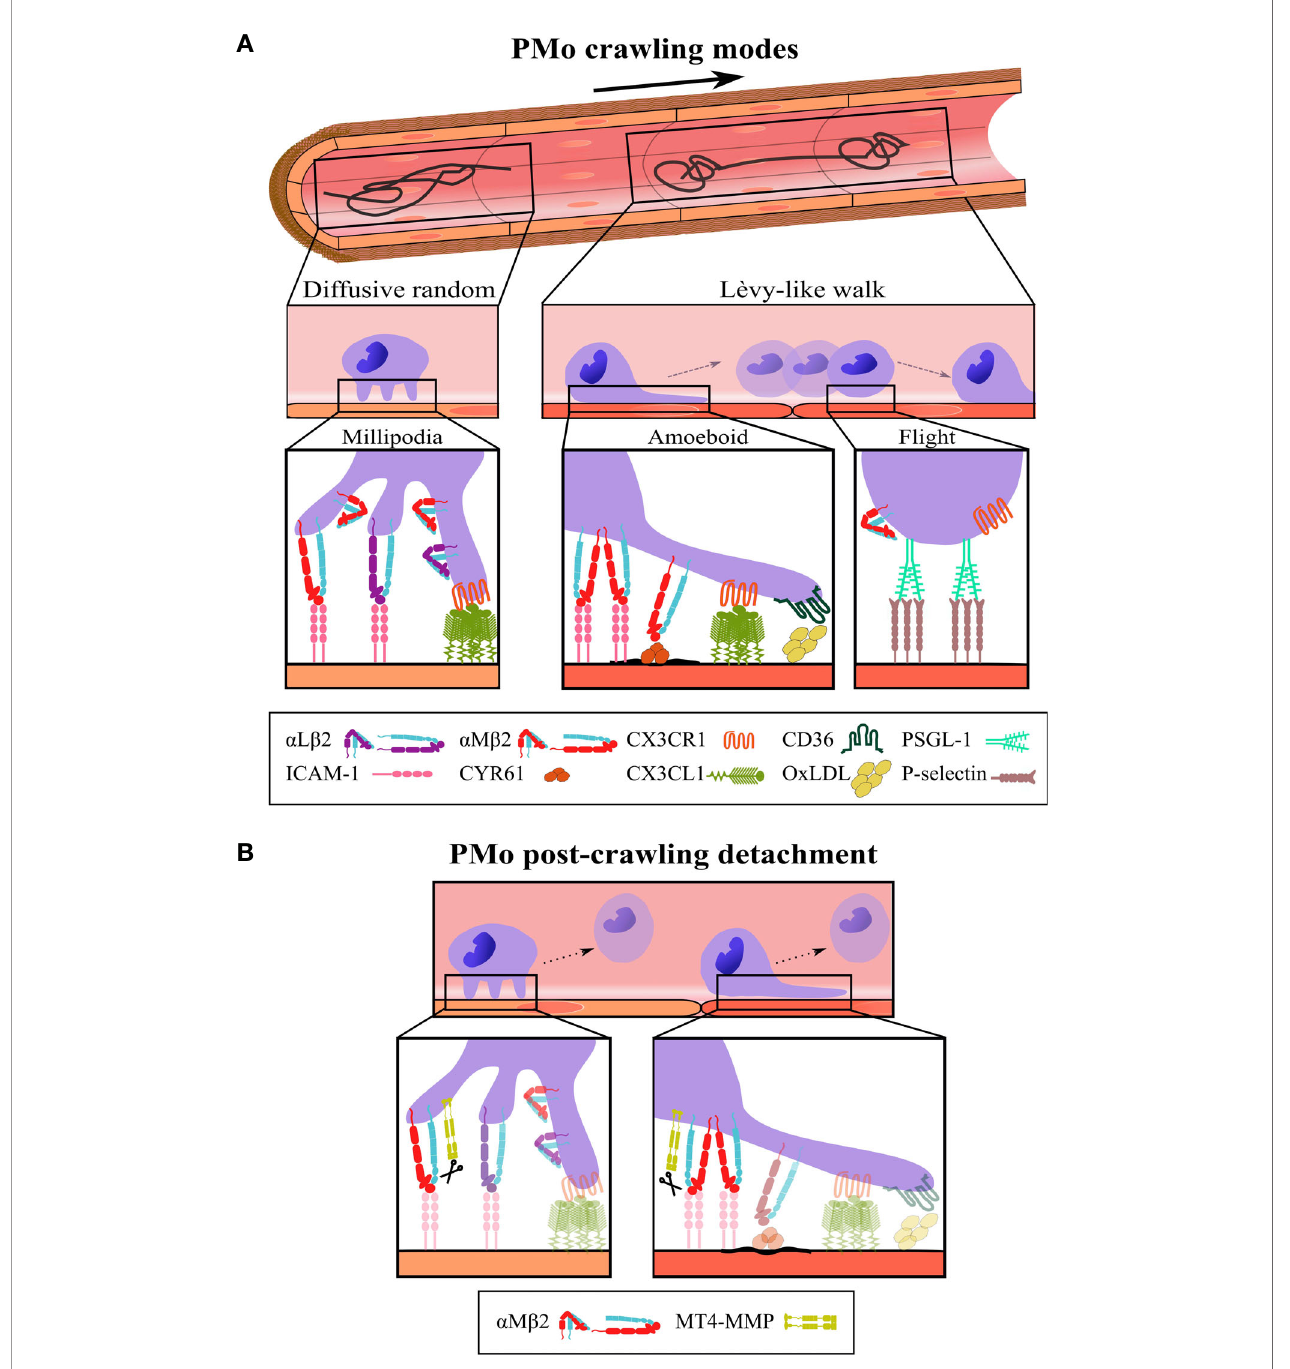
FIGURE 1 | Schematic representation of the different modes, steps, and players in intravascular PMo crawling. ( A , Top) Representative tracks performed by PMo crawling on the vascular endothelium according to the search theory: diffusive random crawling (left) and Lèvy-like walk (right); the bold arrow indicates blood fl ow direction. Middle, side views of PMo morphology (round and elongated) and the corresponding locomotion modes (millipodia and amoeboid) during diffusive random crawling and Lèvy-like walks; in the last, the fl ight phase is also indicated. Bottom, magni fi cations display the molecular players and interactions relevant to each type and step of crawling as described in the text; molecular interactions depicted for the fl ight phase are speculative. (B) The cleavage of a M integrin by the protease MT4-MMP is proposed as a possible mechanism for PMo post-crawling detachment (12), an important step to maintain PMo intravascular surveillance; scissors indicate cleavage. The b 2 integrins are represented in the folded (inactive) and extended (active)